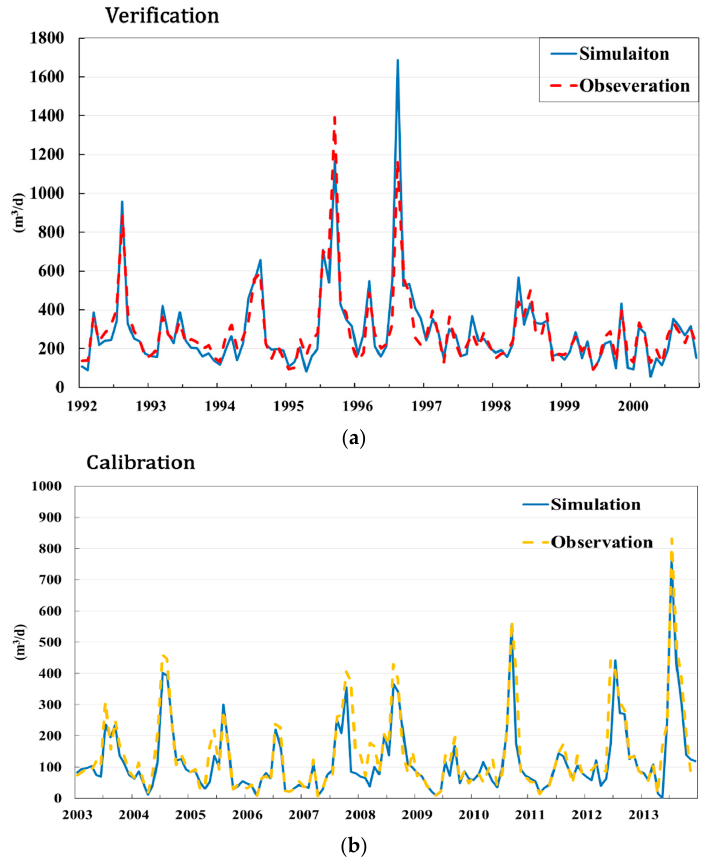
Figure 3. The comparison of SWAT model simulation and observed monthly runoff. ( a ) The verification of the model with the time period of 1992–2000; ( b ) The calibration of the model with the time period of 2003–2013.